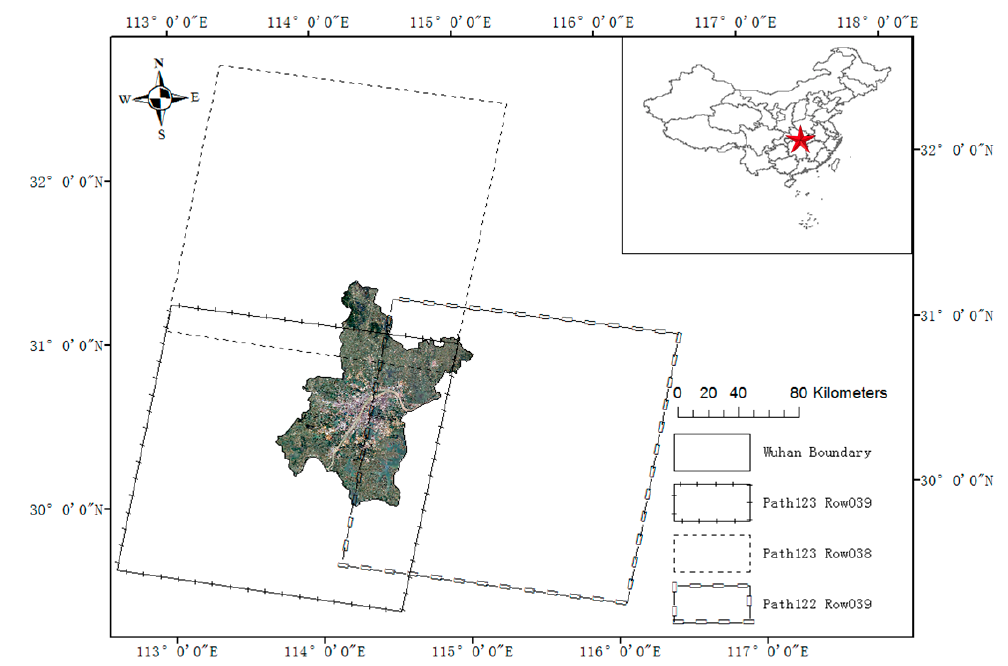
Figure 1. The location and administrative boundary of Wuhan city. The box represents the footprint of Landsat scenes: Path 122 Row 039, Path 123 Row 039, and Path 123 Row 038.